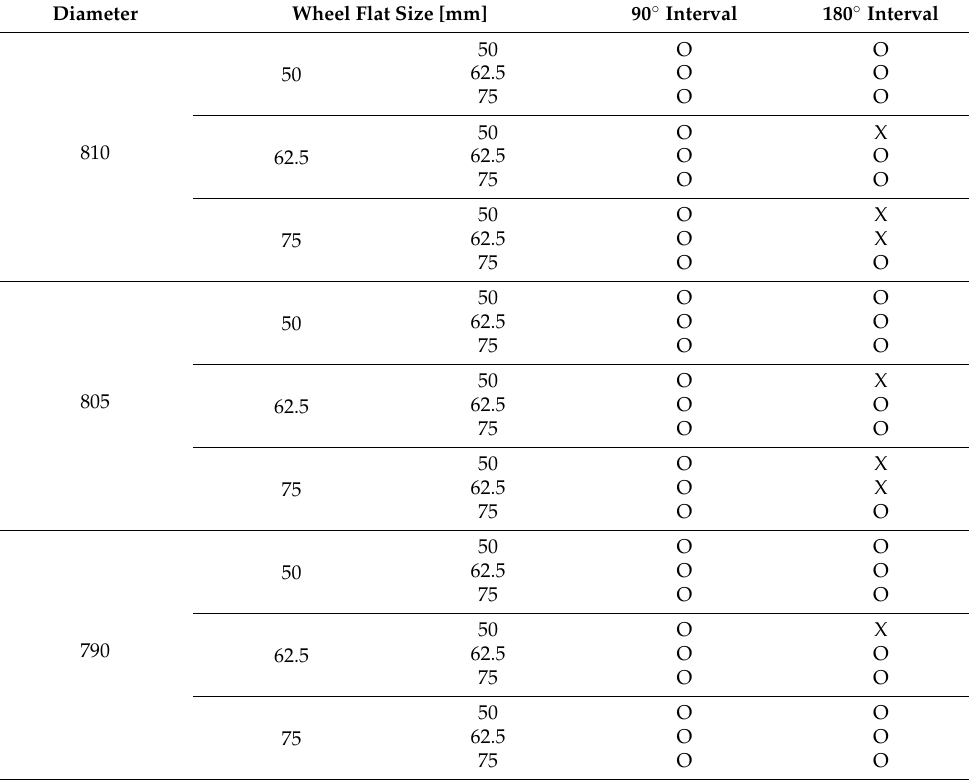
Table A1. Example of wheel flats modeling configuration (2 wheel